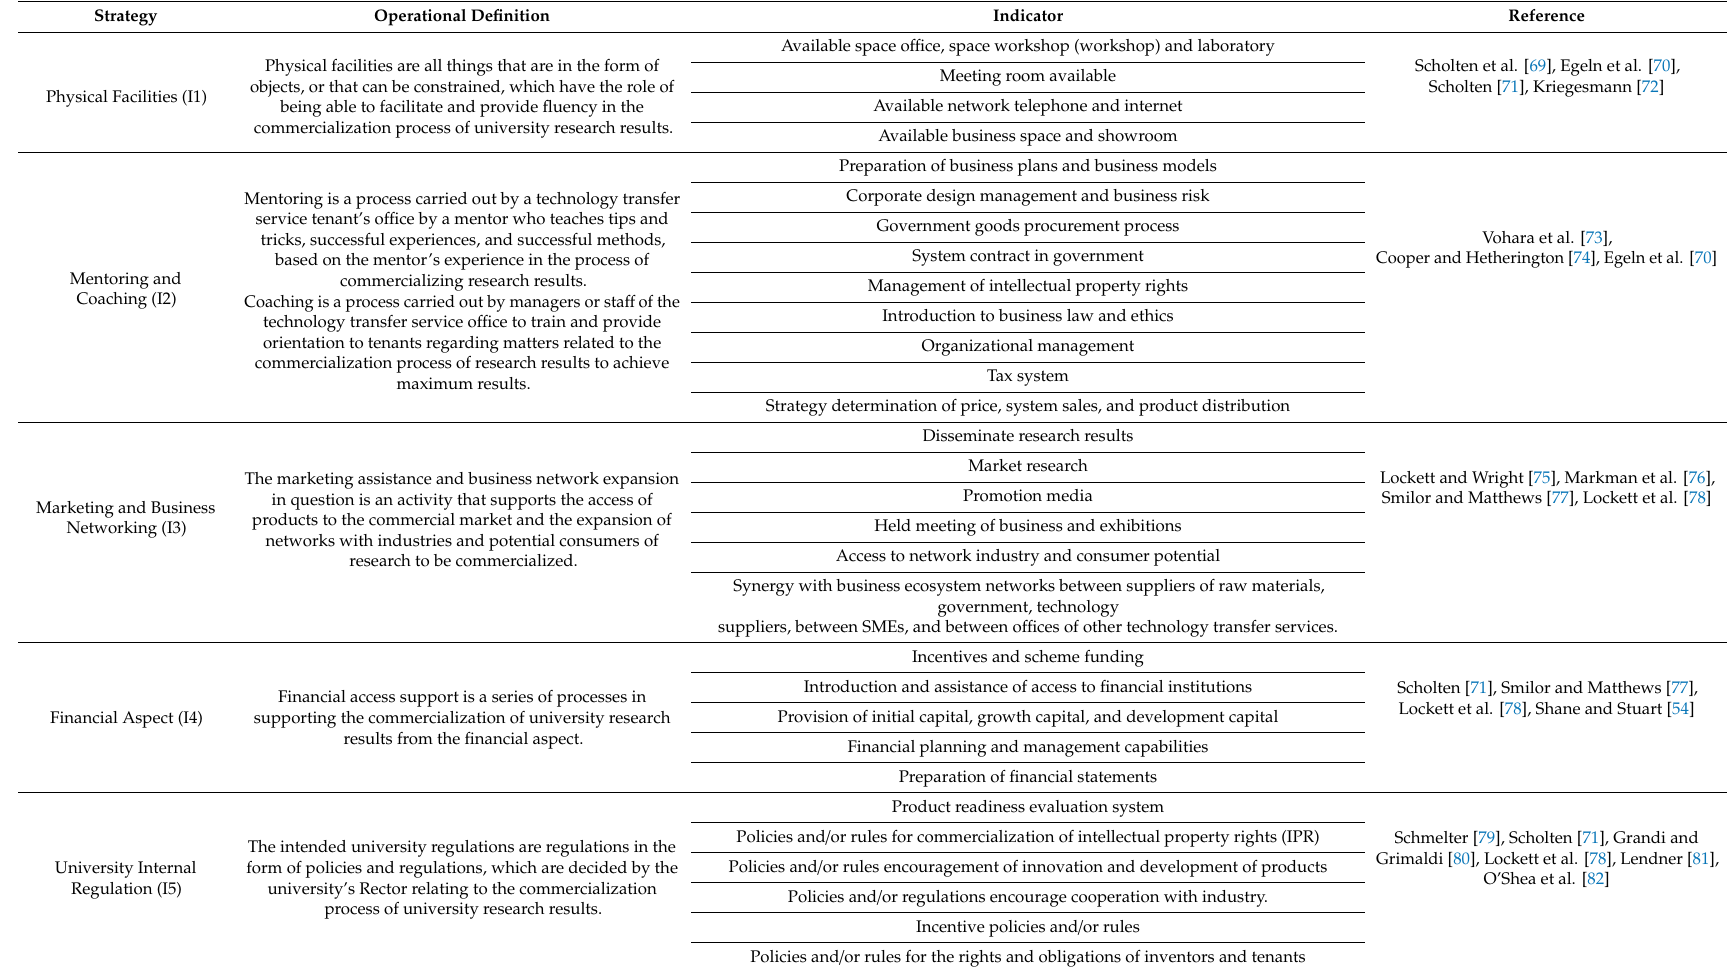
Table 2. Operationalization of input variables and identification of